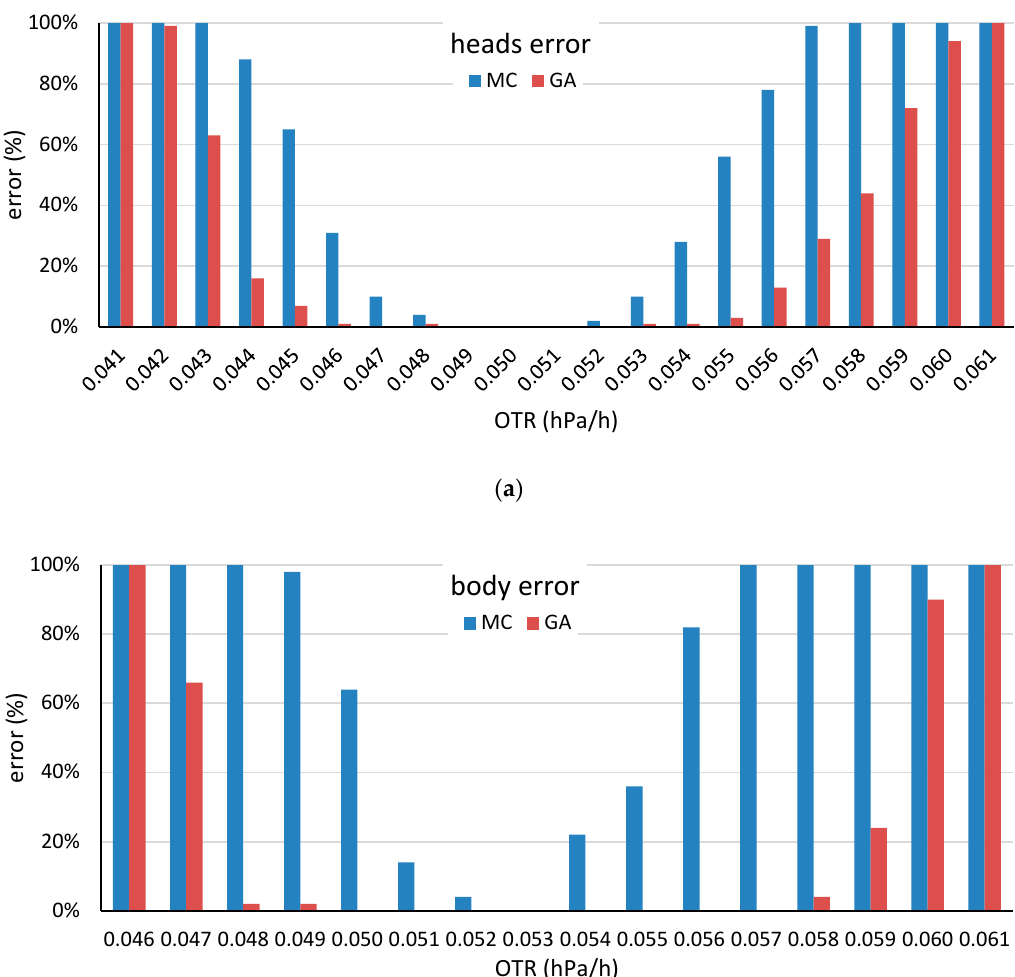
Figure 11. Error rates of the for the head stave ( a ) and the body stave ( b ) by selection method for various target OTR values obtained by using the head and body high-OTR staves. A simulation was regarded as an error if the maximum iteration time was reached without identifying a head or a body barrel with the desired OTR value.